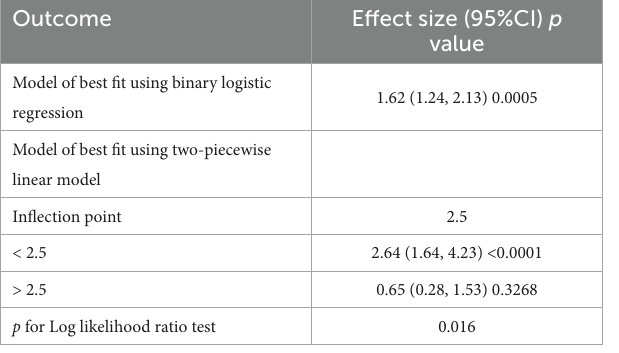
TABLE 5 The results of multivariate analysis using nonadjusted and adjusted Cox regression models.